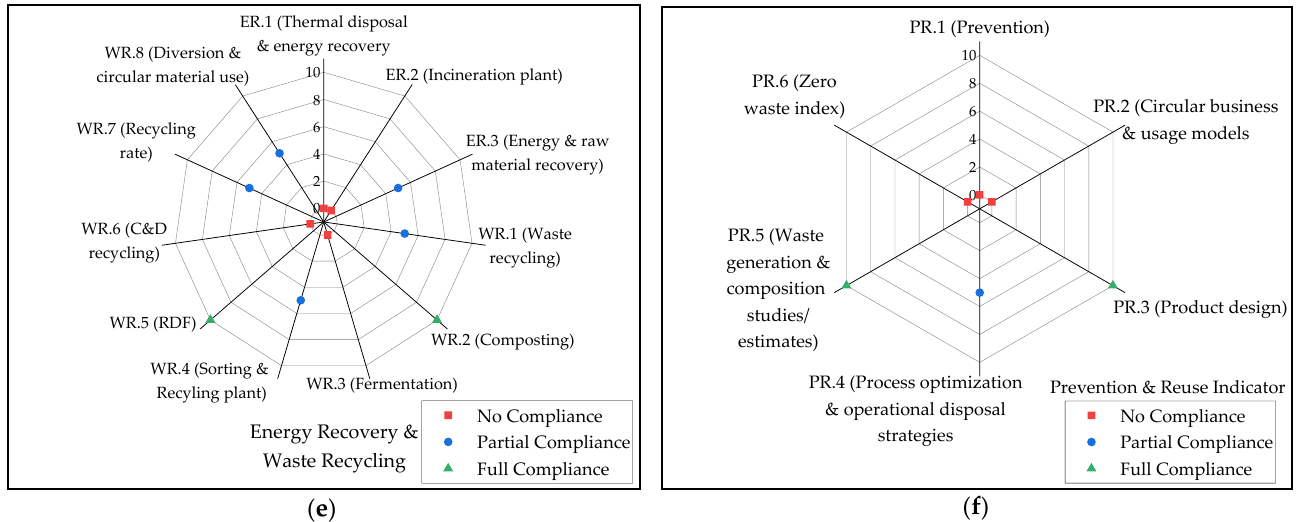
Figure 19. Performance assessment of waste sector: ( a ) Assessment of city against governance indictor; ( b ) Assessment of city against sector & market indicator; ( c ) Assessment of city against waste collection & transportation indictor; ( d ) Assessment of city against waste disposal indictor; ( e ) Assessment of city against energy recovery & waste recycling indictor; ( f ) Assessment of city against waste prevention & reuse